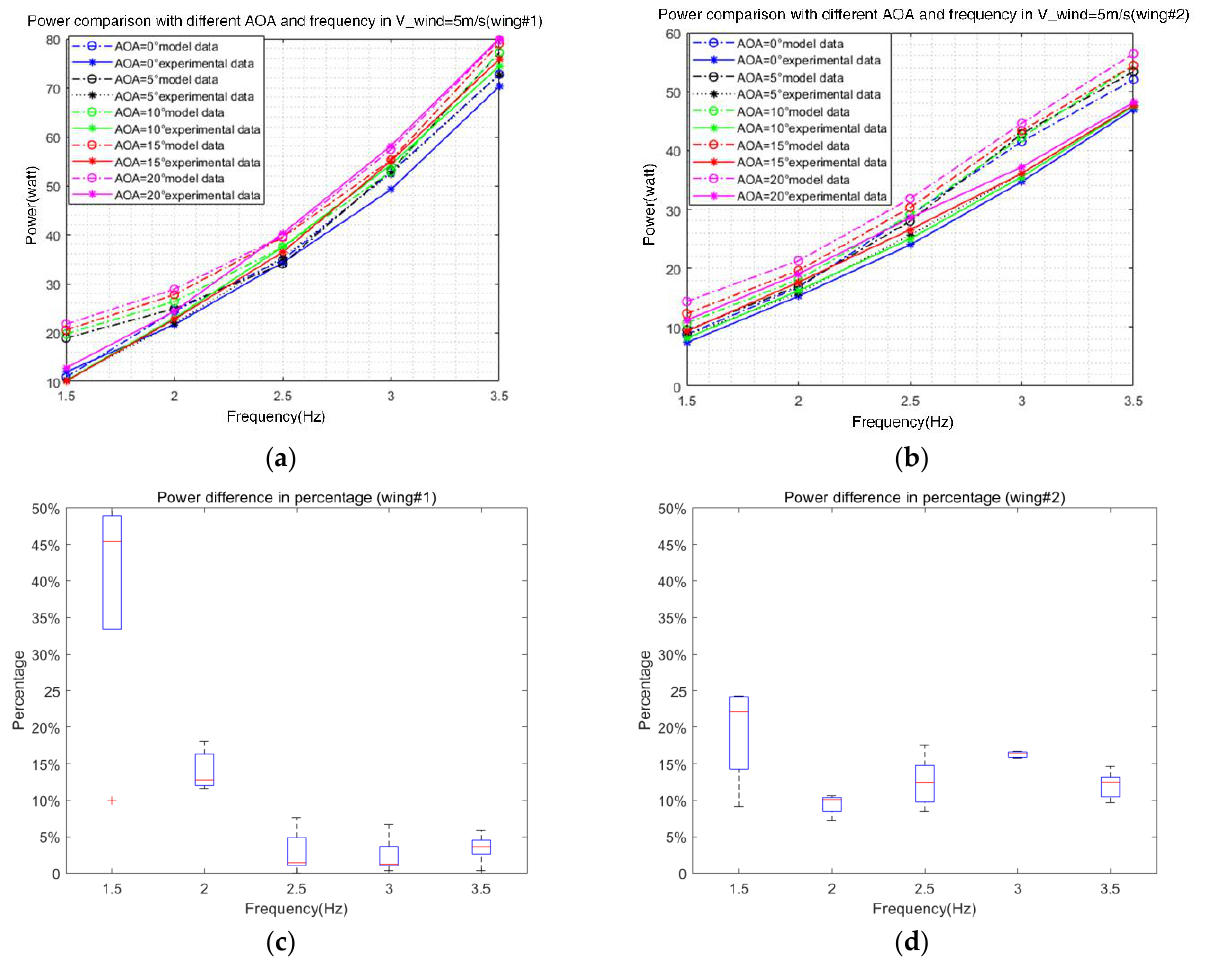
Figure 9. ( a ) Power comparison of wing #1 with different AOA and frequency in V_wing = 5 m/s; ( b ) power comparison of wing #2 with different AOA and frequency in V_wing = 5 m/s; ( c ) power difference in percentage between the experimental and model result of wing #1; ( d ) power difference in percentage between the experimental and model result of wing #2.